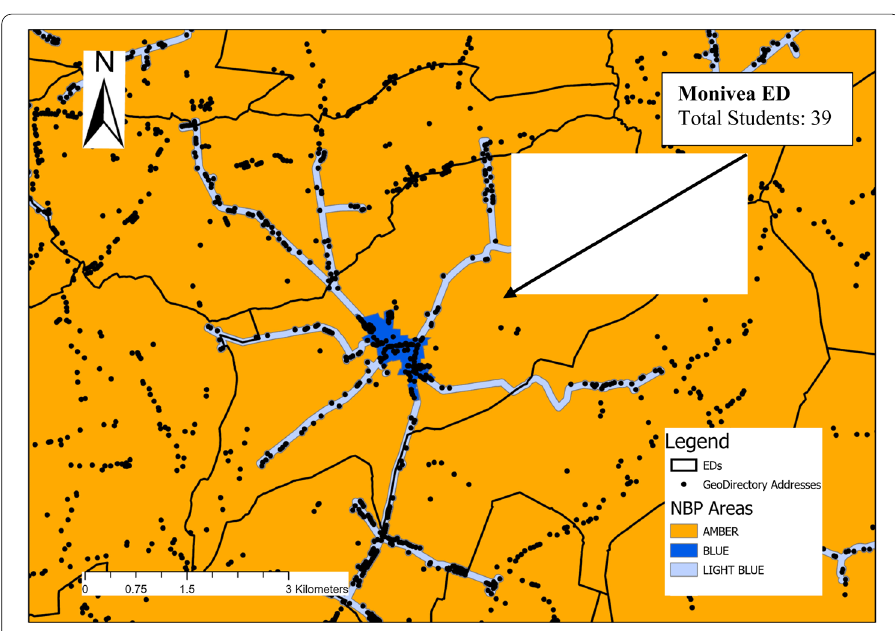
Fig. 2 Geographic information systems approach. Source: Analysis of data from HEA, GeoDirectory, and National Broadband